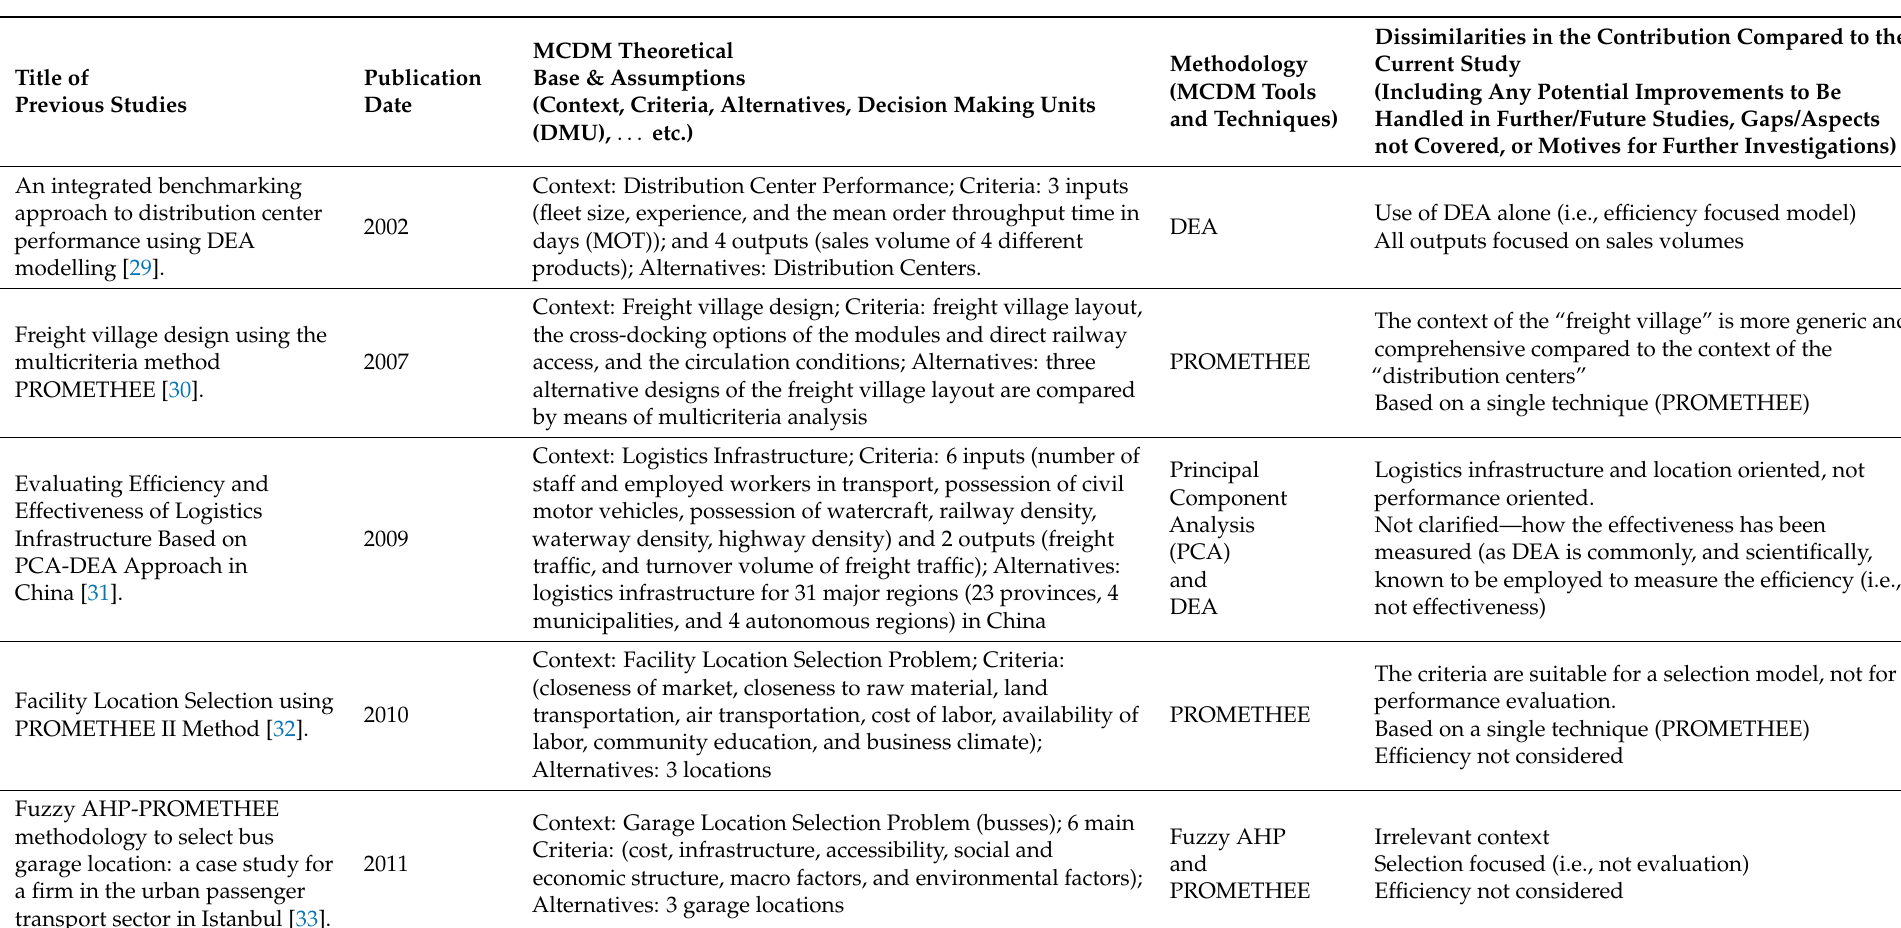
Table 5. List of selected previous research with points of